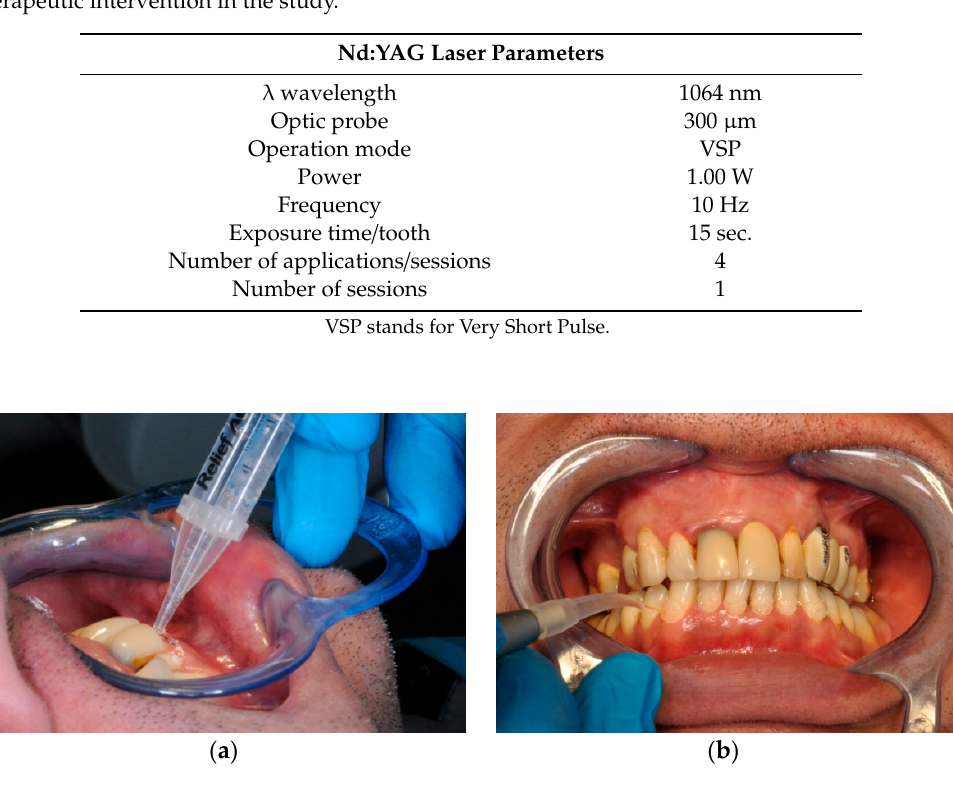
3 Al 5 O 12 ) laser parameters for